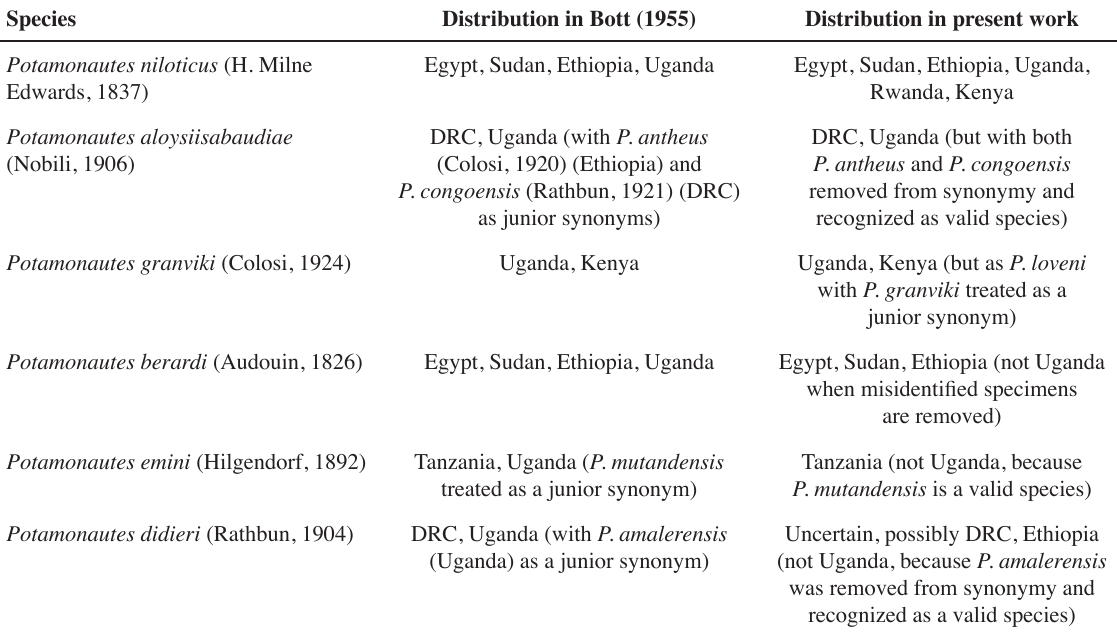
Table 2. Changes in the taxonomic treatment of Ugandan species of freshwater crabs that affect the status of the six species recognized by Bott (1955) vs their taxonomic status in the present